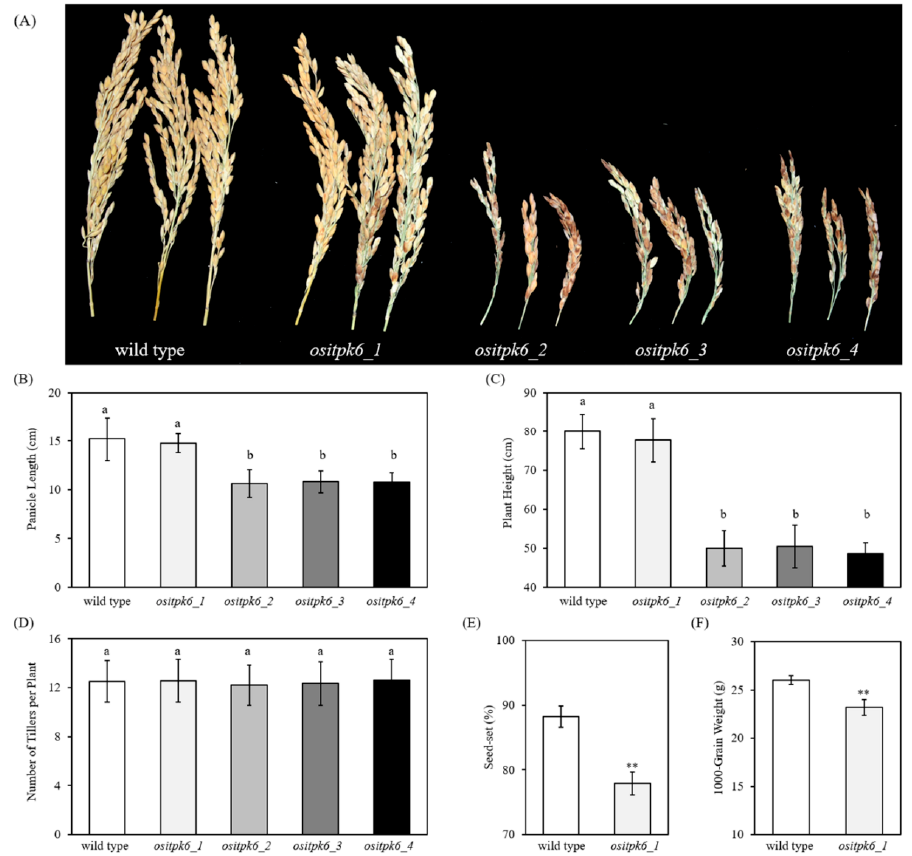
Figure 2. Agronomic traits of mutant OsITPK6 line and wild-type plant. ( A ) Panicle phenotype of mutant OsITPK6 and wild-type plants. ( B – D ) Twenty replicates were performed for four OsITPK6 mutant lines and the wild-type plant. Error bars represent the standard error. The di ff erent letters show significant di ff erences at a probability of p < 0.05. ( E , F ) Twenty replicates were performed for four OsITPK6 mutant lines and the wild type. Error bars represent the standard error. Data with an asterisk(s) are significantly di ff erent from those of the wild type (* p < 0.05, ** p < 0.01).